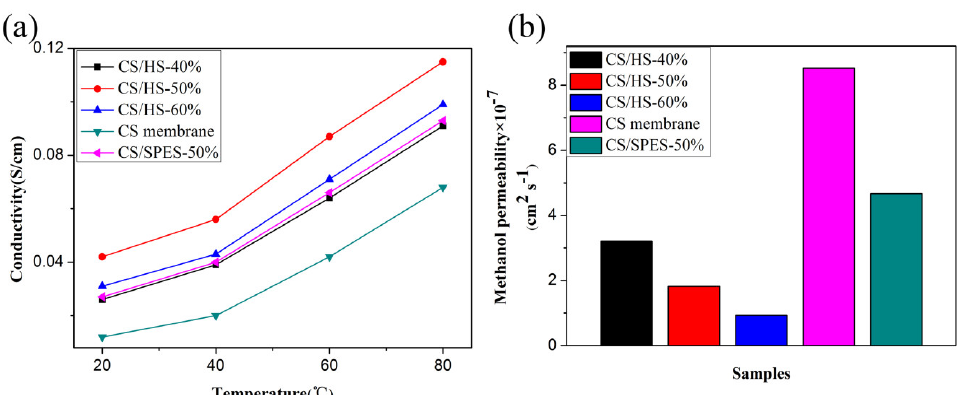
Figure 4. ( a ) Proton conductivity and ( b ) methanol permeability of pure CS and composite